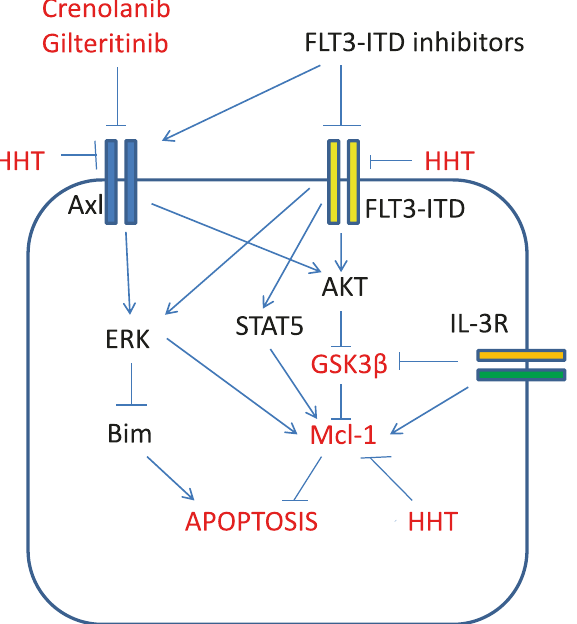
Fig. 7 Mechanistic cascade of apoptosis induction by FLT3-ITD inhibitors and homoharringtonine (HHT). FLT3-ITD, Axl and IL-3 receptor inactivate GSK3b and increase Mcl-1 protein to block apoptosis. FLT3-ITD inhibitors activate GSK3b by inhibiting FLT3-ITD and Axl and then decrease Mcl-1 protein level. HHT decreases the protein levels of Mcl-1, FLT3-ITD and Axl, and enhances FLT3-ITD inhibitor-induced